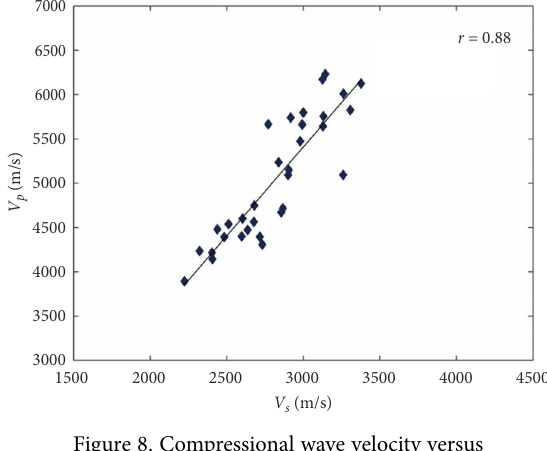
Figure 6. Density versus grain size (GS)